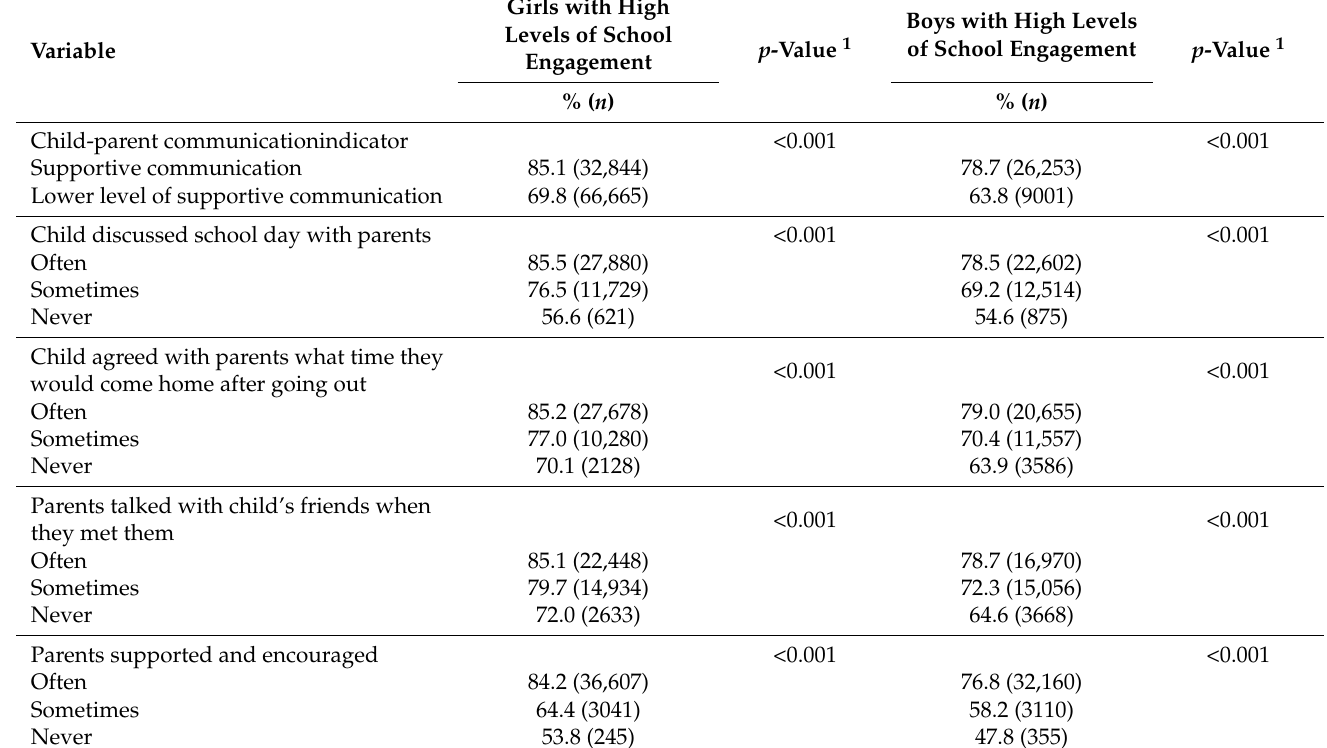
Table 5. Associations between child-parent relationships of children aged 9–11 and school engagement